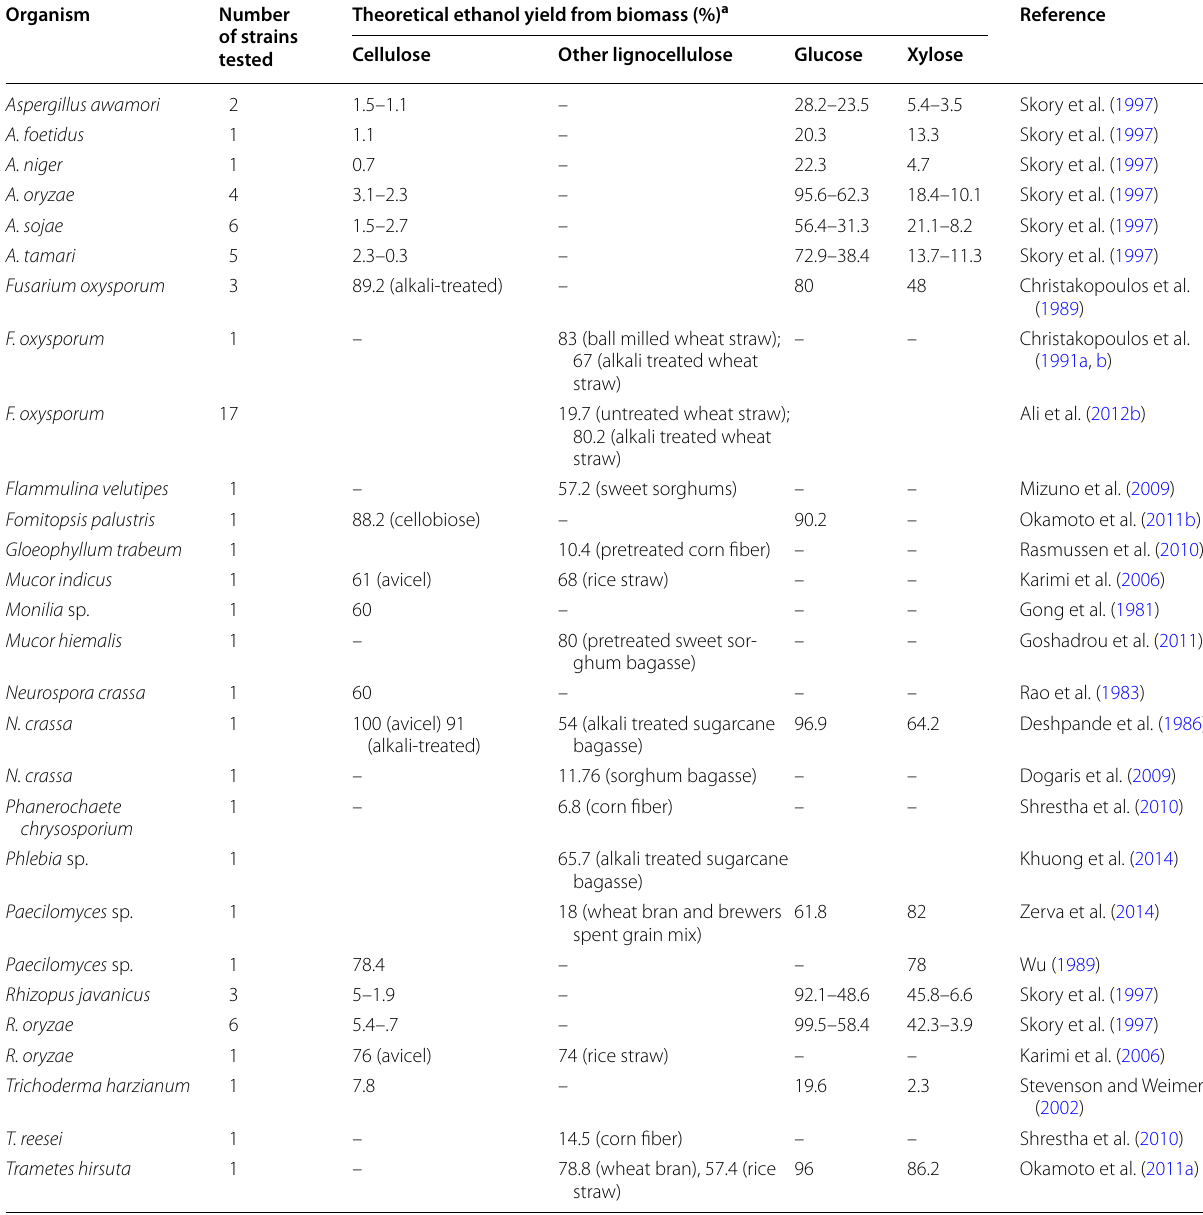
Table 1 The potential of filamentous fungi as CBP agents